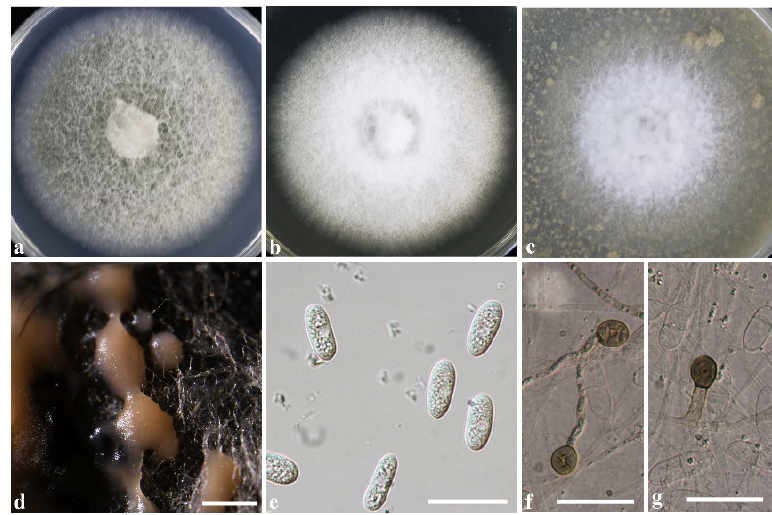
Figure 5. Culture characteristics and microscopic features of C. aenigma (isolate GT-42). ( a – c ) Seven- day-old of colonies on PDA, MEA, and OA medium, respectively. ( d ) Conidiomata. ( e ) Conidia. ( f , g ) Appressoria. Scale bars: ( b ) = 500 μ m; ( e – g ) = 20 μ m.